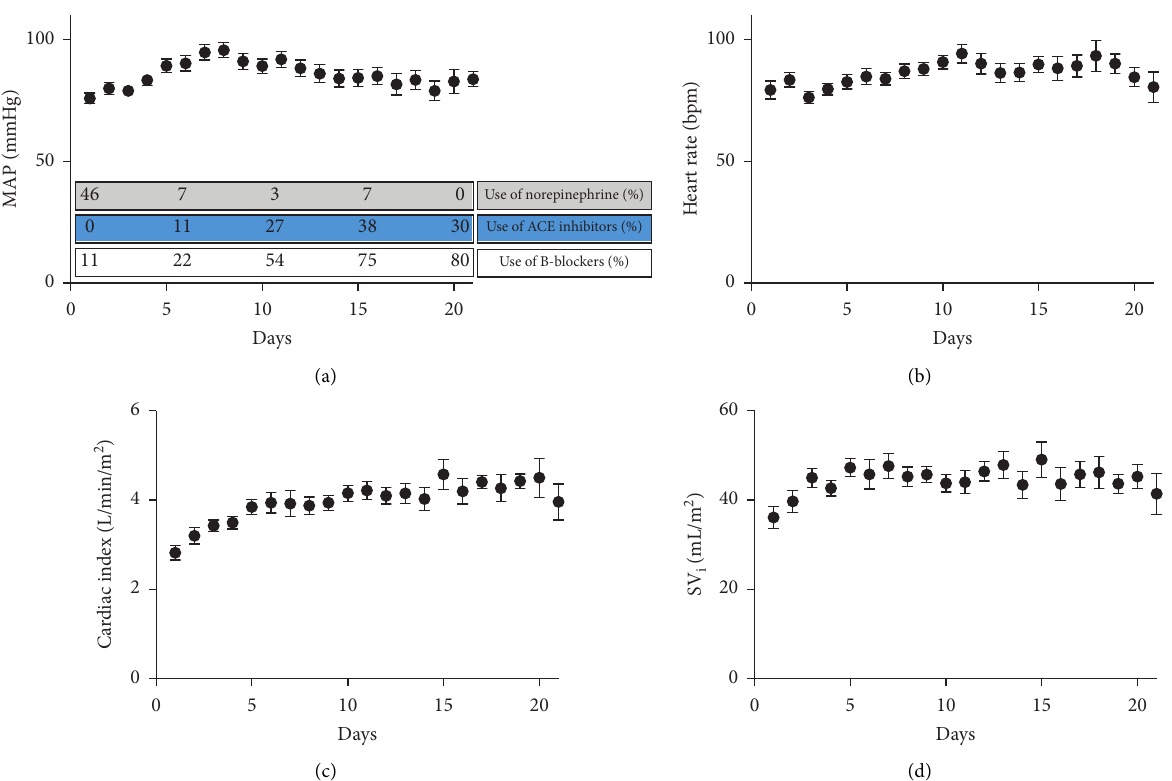
Figure 1: Circulatory characteristics (I) of COVID-19 patients. MAP: mean arterial pressure; bpm: beats per minute; SV